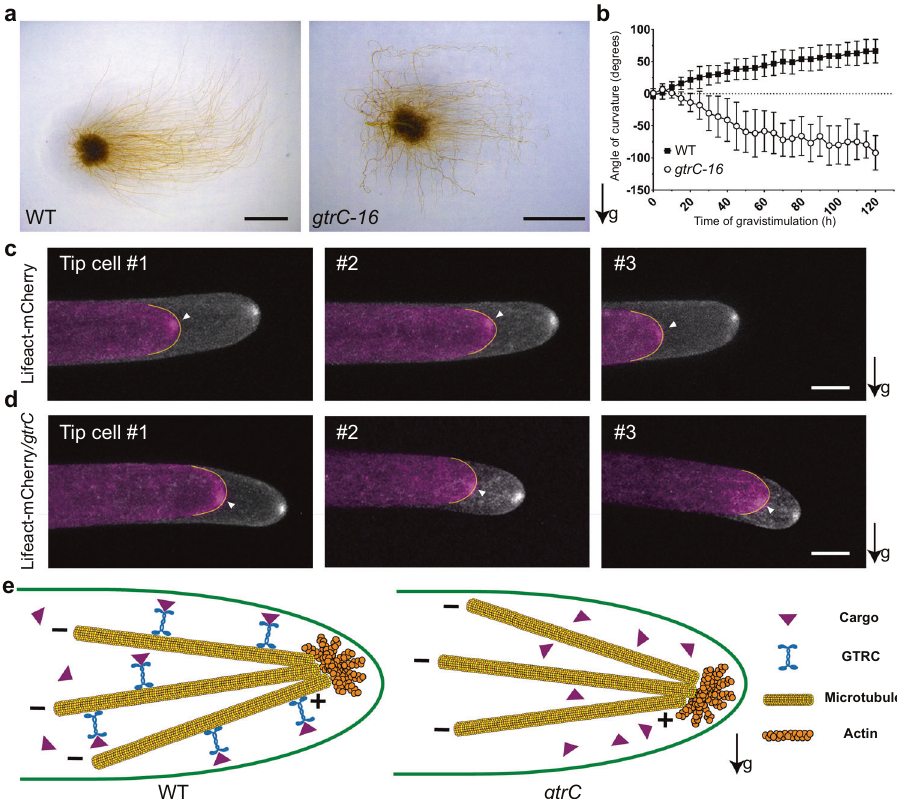
Fig. 6 Disruption of GTRC reversed the gravity-triggered asymmetric distribution of actin fi laments. a Three-week dark-grown WT protonemata showed negative gravitropism and gtrC-16 protonemata showed positive gravitropism after gravistimulation for 2 weeks on vertically orientated culture plate. b Kinetic curved angles of WT and gtrC-16 fi laments under gravistimulation (means ± s.d., n ≥ 18). Source data are provided as a Source Data fi le. c The apical cells of Lifeact-mCherry protonemata growing upwards under gravistimulation. Actin tended to accumulate at the upper part of tip region (white arrowheads). d The apical cells of Lifeact-mCherry/ gtrC protonemata growing downwards under gravistimulation. Actin tended to accumulate at the lower part of tip region (white arrowheads). In ( c , d ), protonemata expressing Lifeact-mCherry were grown in the dark vertically for 1 week and then turned 90 degrees to be gravistimulated. Three representative tip cells were shown for each genotype, and the mCherry signals at two time points were merged to show cell elongation. Magenta and white represent earlier and later time points respectively, with an interval of around half an hour. Yellow lines depict the contour of tip cells at earlier time points. For each genotype, the fl uorescence of 10 cells was collected. Arrows labeled with “ g ” indicate the direction of gravity vectors. Scale bars, 10 μ m. e The model of the roles of GTRC in gravitropism. In WT protonemata, after gravistimulation, motor GTRC transfers unknown cargoes to the minus end of microtubules, resulting in the accumulation of actin fi laments at the upper region of apical cell, which triggers negative gravitropism. In gtrC protonemata, de fi ciency of GTRC leads to abnormal cargo distribution, resulting in accumulation of actin fi laments at the lower region of apical cell, which triggers positive